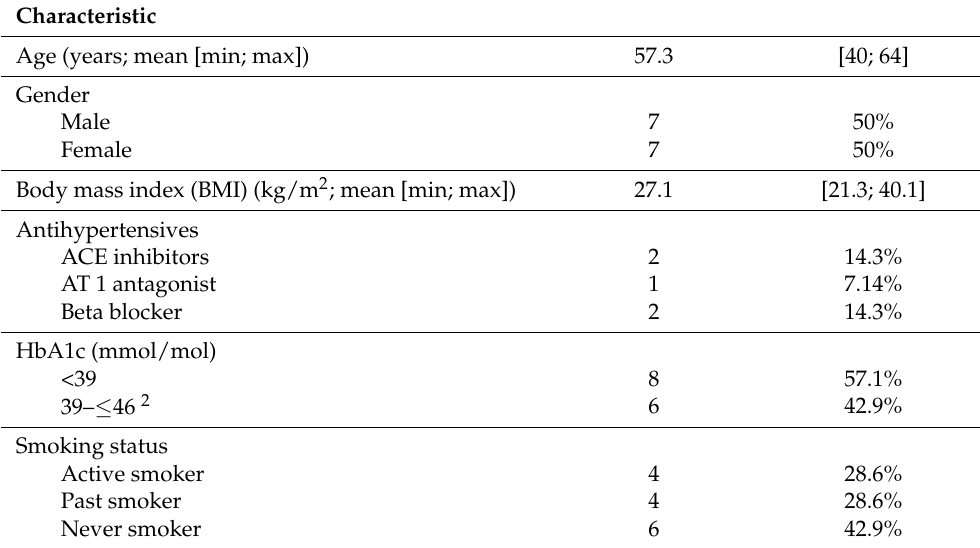
Table 1. Characteristics of the trial participants at baseline (n = 14, safety population) 1